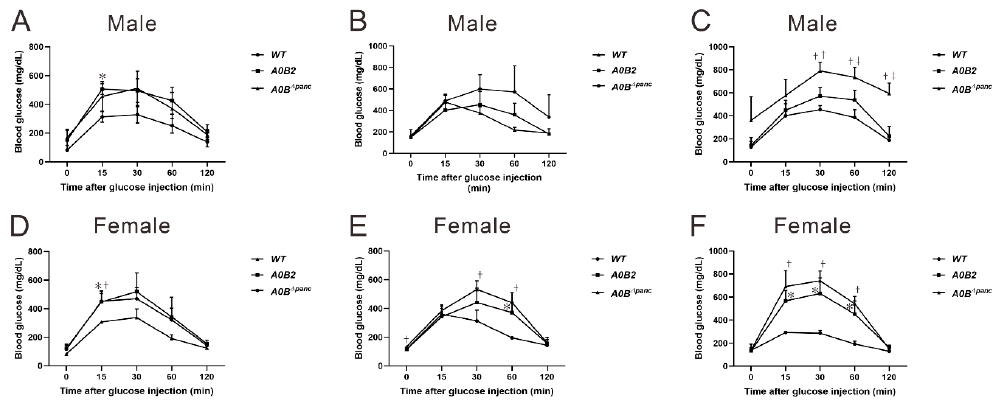
Figure 2. Effect of Mafb deletion on glucose clearance activity in A0B Δ panc mice. The intraperitoneal glucose tolerance test (IPGTT) was performed at designated timepoints (0, 4, and 16 week post-TAM) between male ( A – C ) and female ( D – F ) mice of indicated genotypes. Prior to IPGTT, 2 g/kg glucose was intraperitoneally injected after a 16 h period starvation. The data are from 3–7 mice of indicated genotypes. * A0B2 vs WT , p < 0.05; † A0B Δ panc vs WT , p < 0.05; ‡ A0B2 vs A0B Δ panc , p < 0.05. The error bars indicate SD.